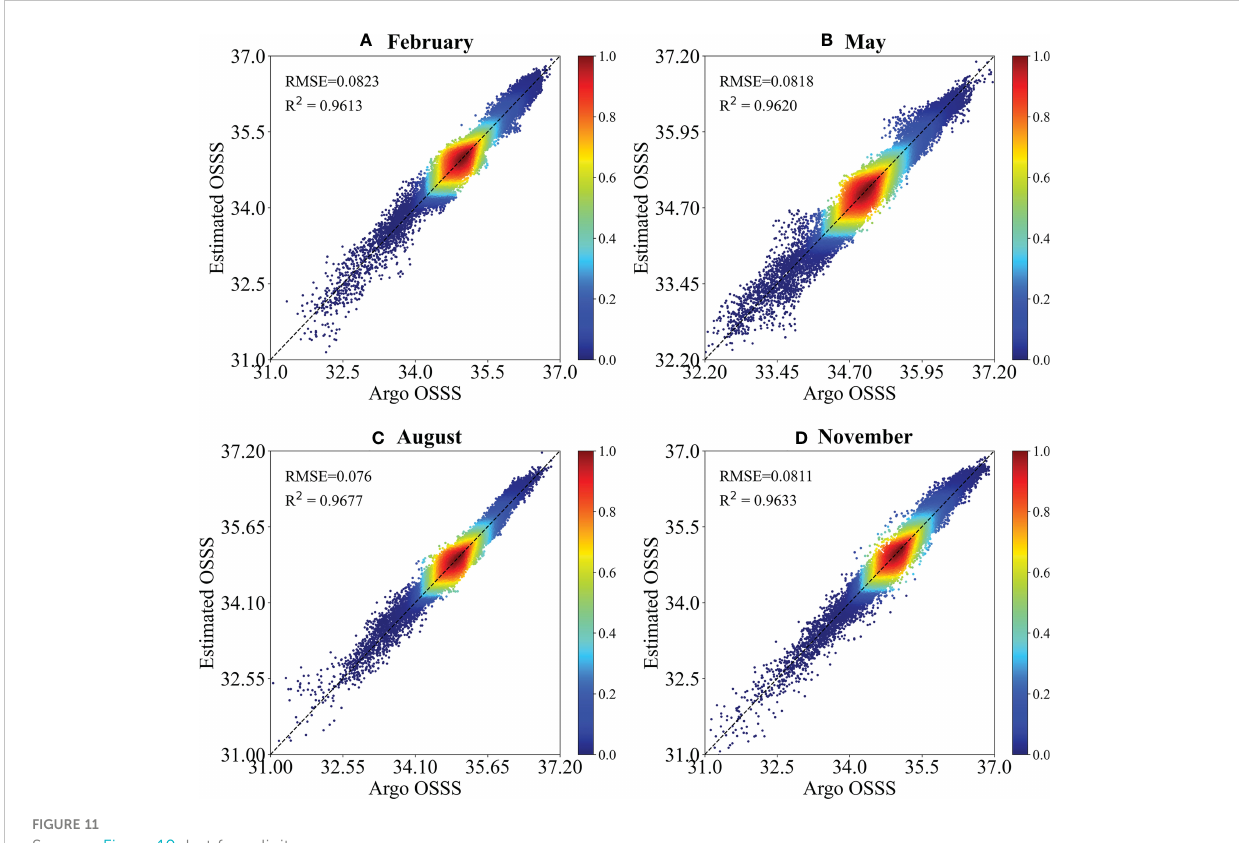
FIGURE 11 Same as Figure 10, but for salinity.